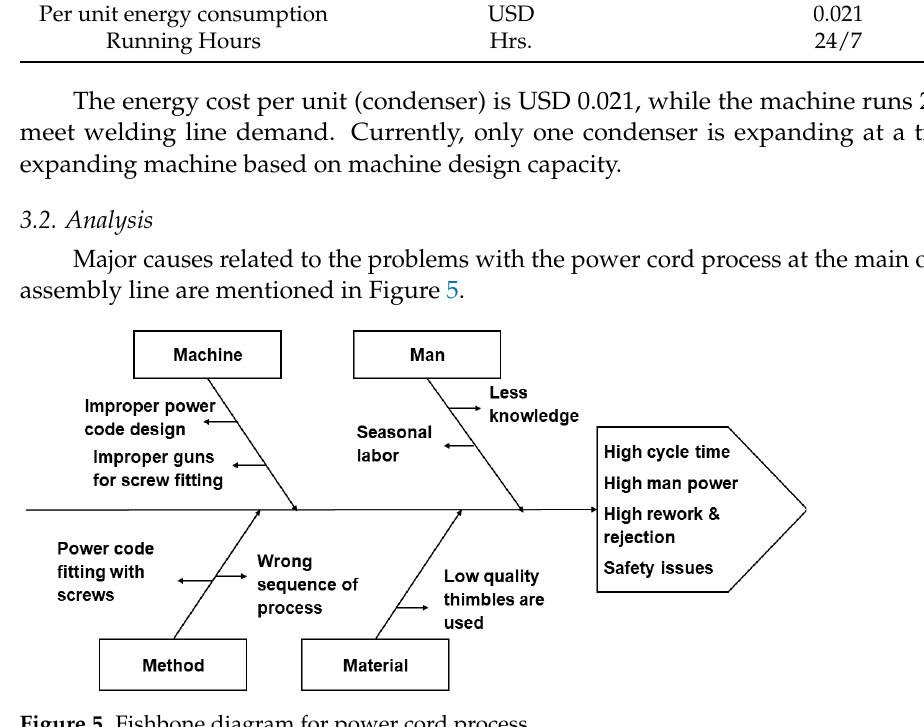
Figure 6. Fishbone diagram for expanding machine (Condenser manufacturing).